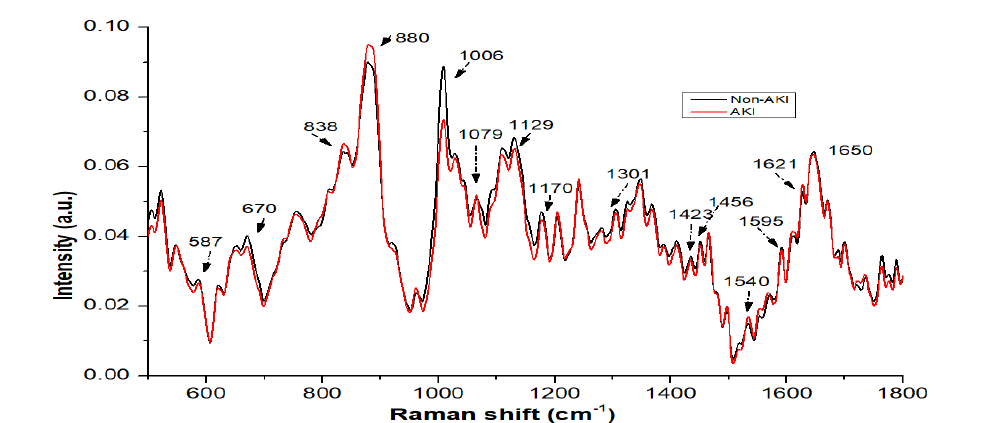
Figure 1. The mean Raman spectrum from 120 non-AKI and 80 AKI patients.